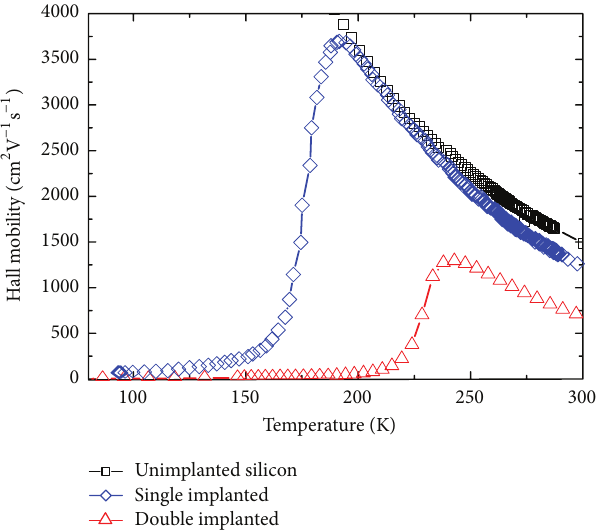
) as a function il